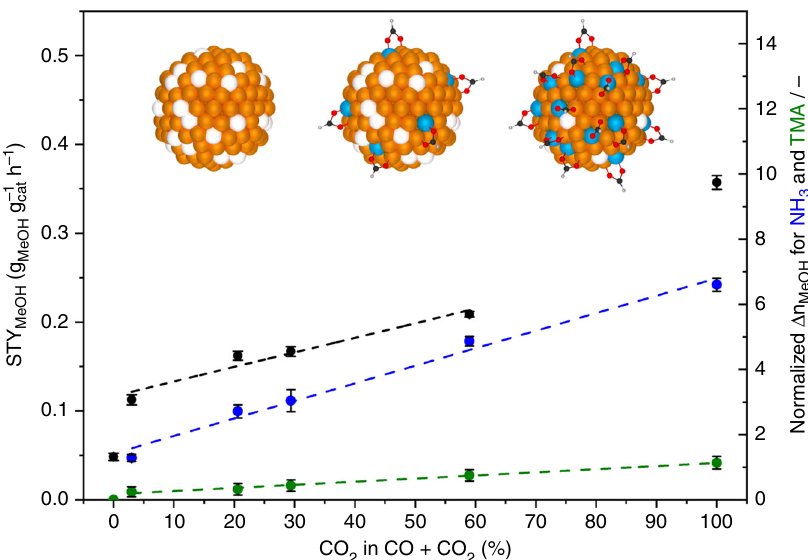
Fig. 3 In fl uence of CO 2 on the methanol productivity and on the oxidation state of the catalyst surface. Correlation of the methanol productivity (black points and line) and of the normalized Δ n MeOH values (Supplementary Note 2) of NH 3 (blue points and line) and TMA (green points and line) as a function of the CO 2 content in the syngas from pure CO hydrogenation (0%) to pure CO 2 hydrogenation (100%). Illustrations: Metallic Cu 0 particles (orange balls), metallic Zn 0 species (white balls), positively charged Zn species (blue balls) and formate as adsorbates. The error bars were determined by measuring every point fi ve